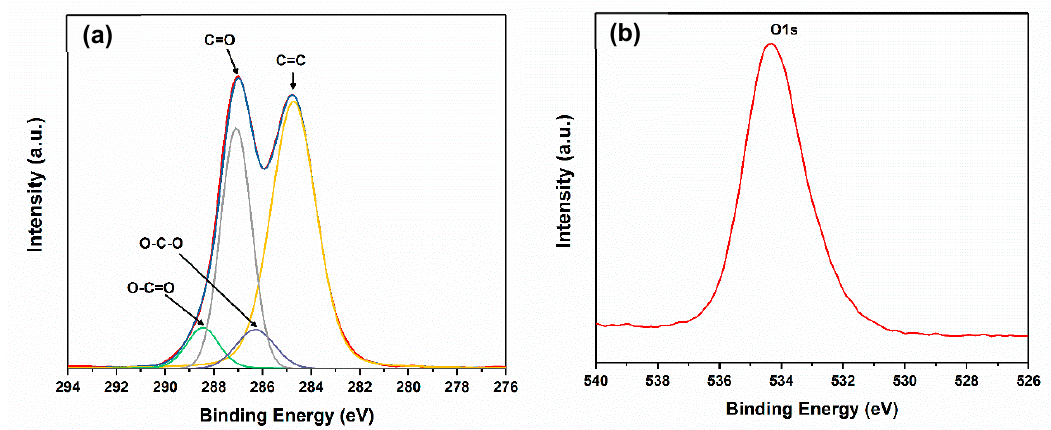
Figure 3. ( a ) C1s and ( b ) O1s XPS spectra of GO nanosheets.